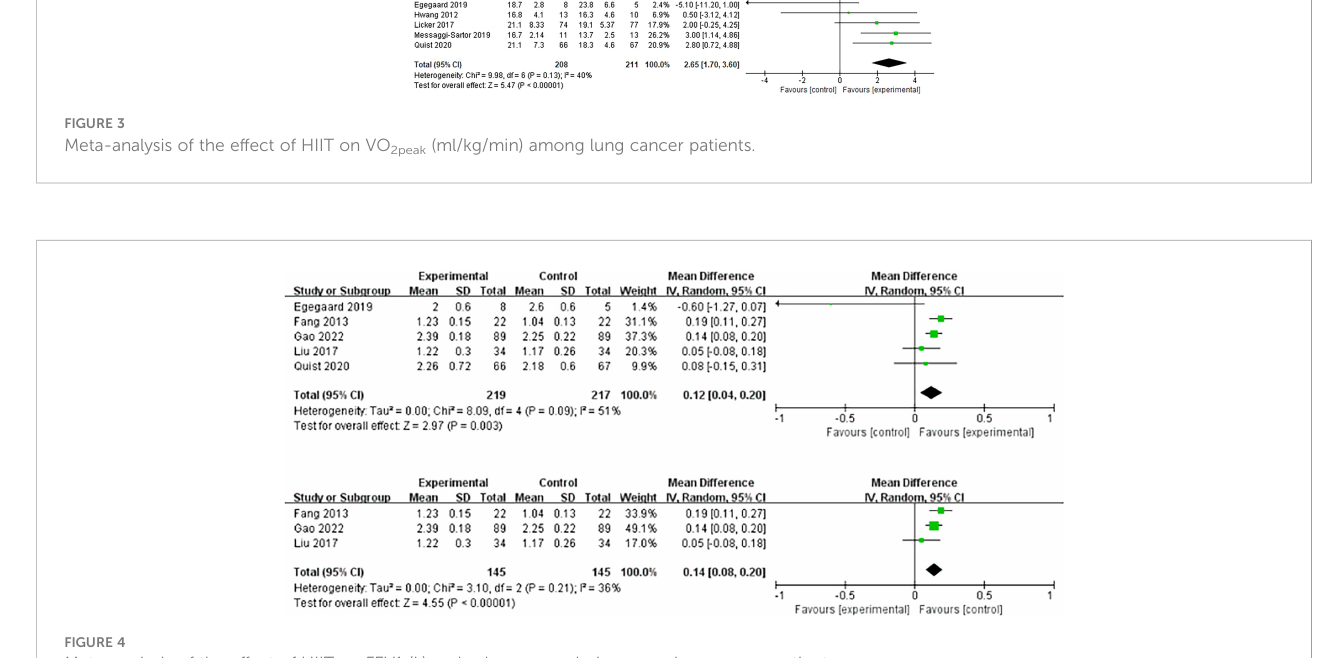
FIGURE 4 Meta-analysis of the effect of HIIT on FEV1 (L) and subgroup analysis among lung cancer patients.